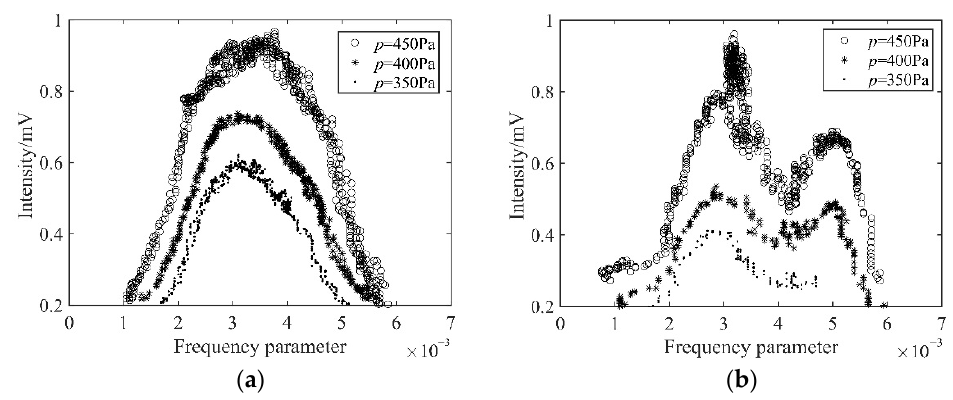
Figure 8. Experimental results of the profile of the intensity tuning curve in the ring gyro. ( a ) Ne 20 :Ne 22 = 7:3, inflation pressures are 350 Pa, 400 Pa, and 450 Pa; ( b ) natural Ne isotopes, inflation pressures are 350 Pa, 400 Pa, and 450 Pa.